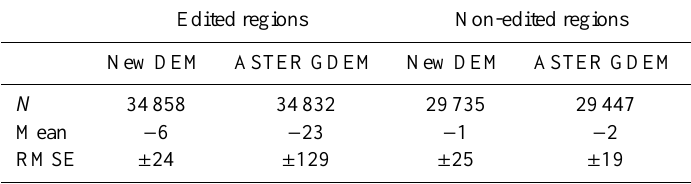
Table 2b. Comparisons between the new DEM and ASTER GDEM for both edited and non-edited regions (accuracies are relative to ICESat in metres). “Non-edited” signifies regions where the original GDEM is considered to be of high-quality. N.B. the new DEM was down- sampled to 100m and filtered in the “non-edited” regions, which explains the higher RMSE. Edited